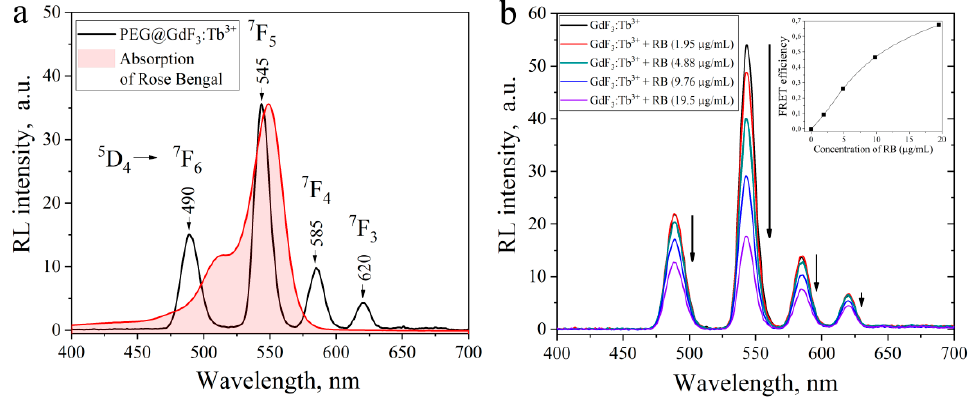
Figure 3. ( a ) X-ray-excited optical luminescence (XEOL) spectrum of PEG@GdF 3 :Tb 3+ (10%) nanoparticles excited by X-ray irradiation (35 kV, 16 mA); ( b ) A decrease of XEOL intensity of colloidal PEG@GdF 3 :Tb 3+ (10%)–RB nanocomposite solution with the amount of RB conjugated on the NPs’ surface through the fluorescence resonance energy transfer (FRET) process.